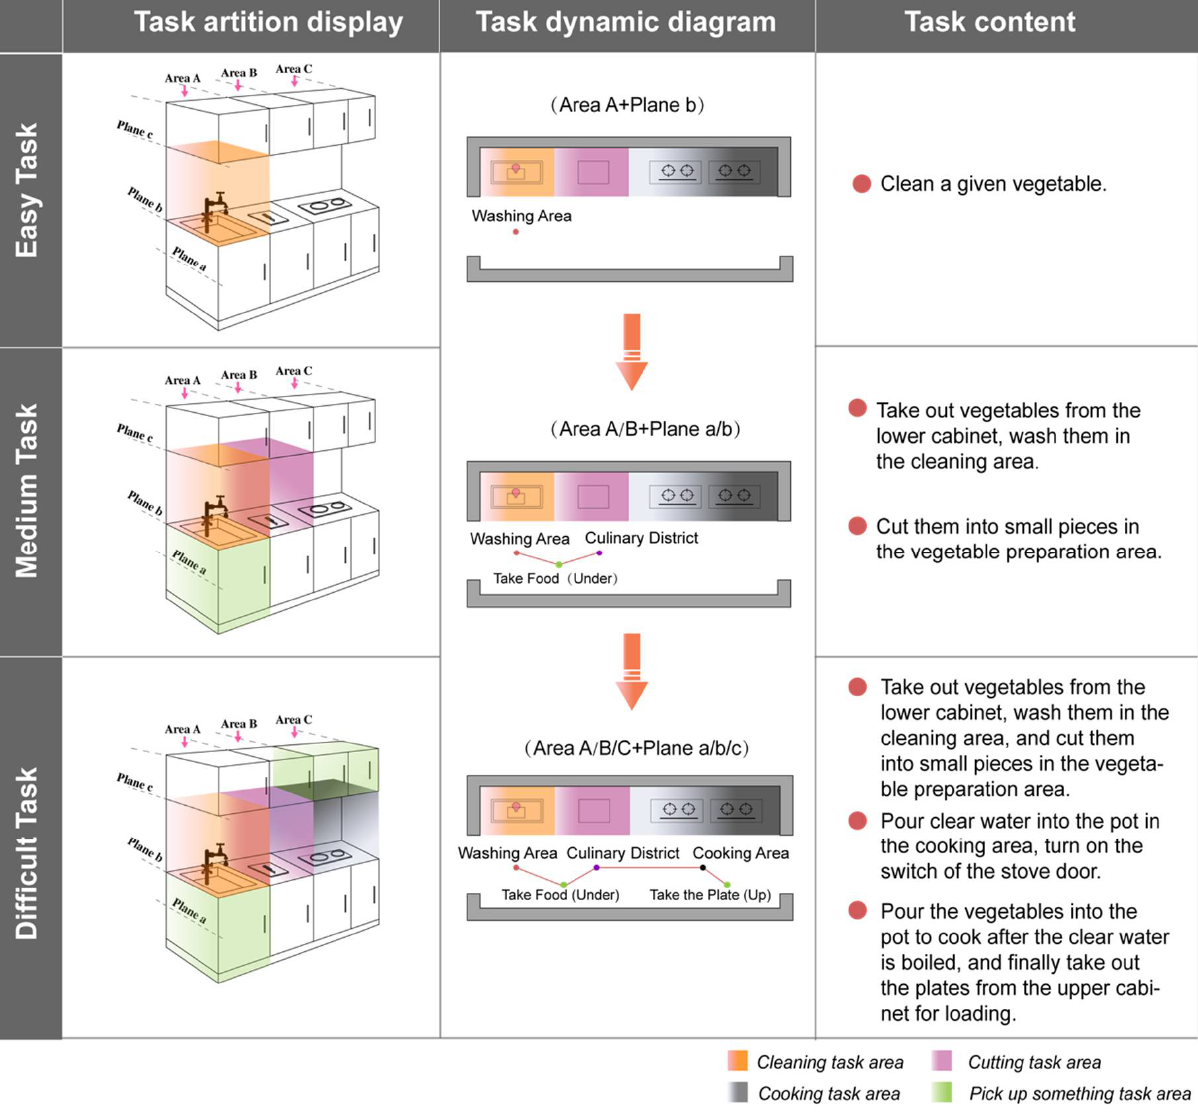
Figure 2. Examples of different tasks in the kitchen.